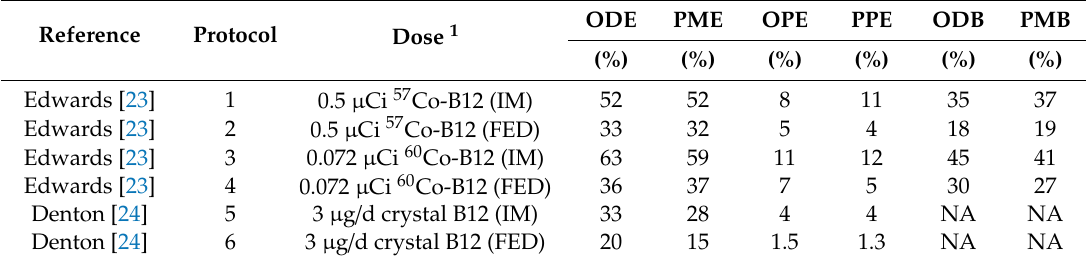
Table A1. Summary of model simulation results for experimental Table B1. Summary of model simulation results for experimental protocols.